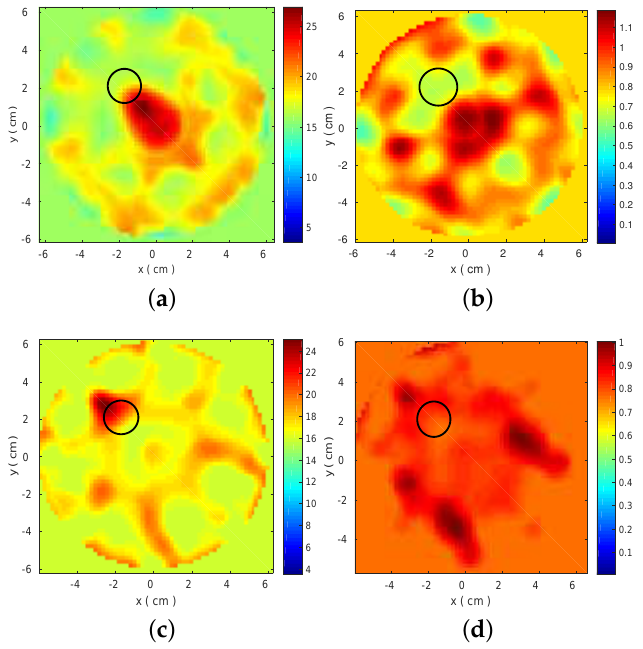
Figure 7. 2-D reconstructed complex permittivity distributions from 3-D CST data in 90% corn syrup, using our frequency selection approach illustrated in Figure 6. Resulting distributions of ( a ) (cid:101) (cid:48) and ( b ) (cid:101) (cid:48)(cid:48) by frequency hopping in 1.5–1.8 GHz; and ( c ) (cid:101) (cid:48) and ( d ) (cid:101) (cid:48)(cid:48) by frequency hopping in 2.5–2.8